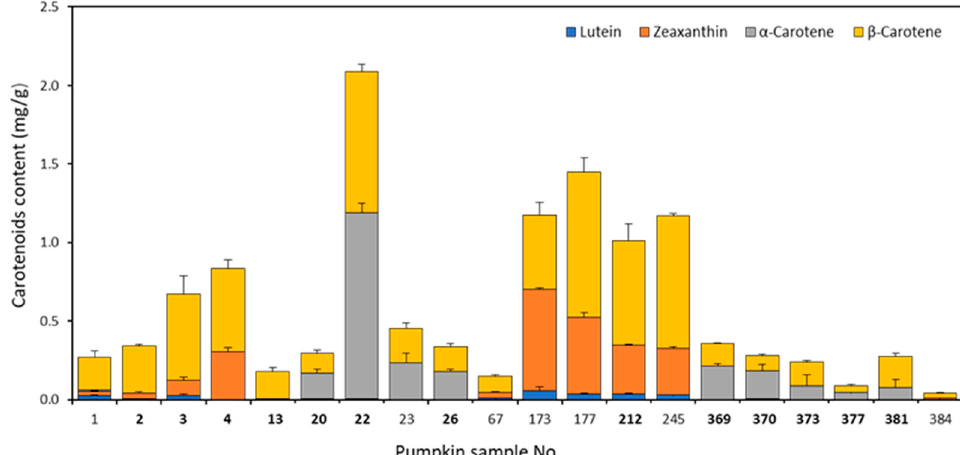
Figure 6. Total carotenoid content in pumpkin samples measured by HPLC-DAD. Results are expressed as mg/g dry matter. The cumulative carotenoid content for each sample is broken down into the four carotenoids calculated (lutein, zeaxanthin, α -carotene, β -carotene). Serbian samples are indicated in bold. Results are expressed as mean values ± S.D ( n = 2).